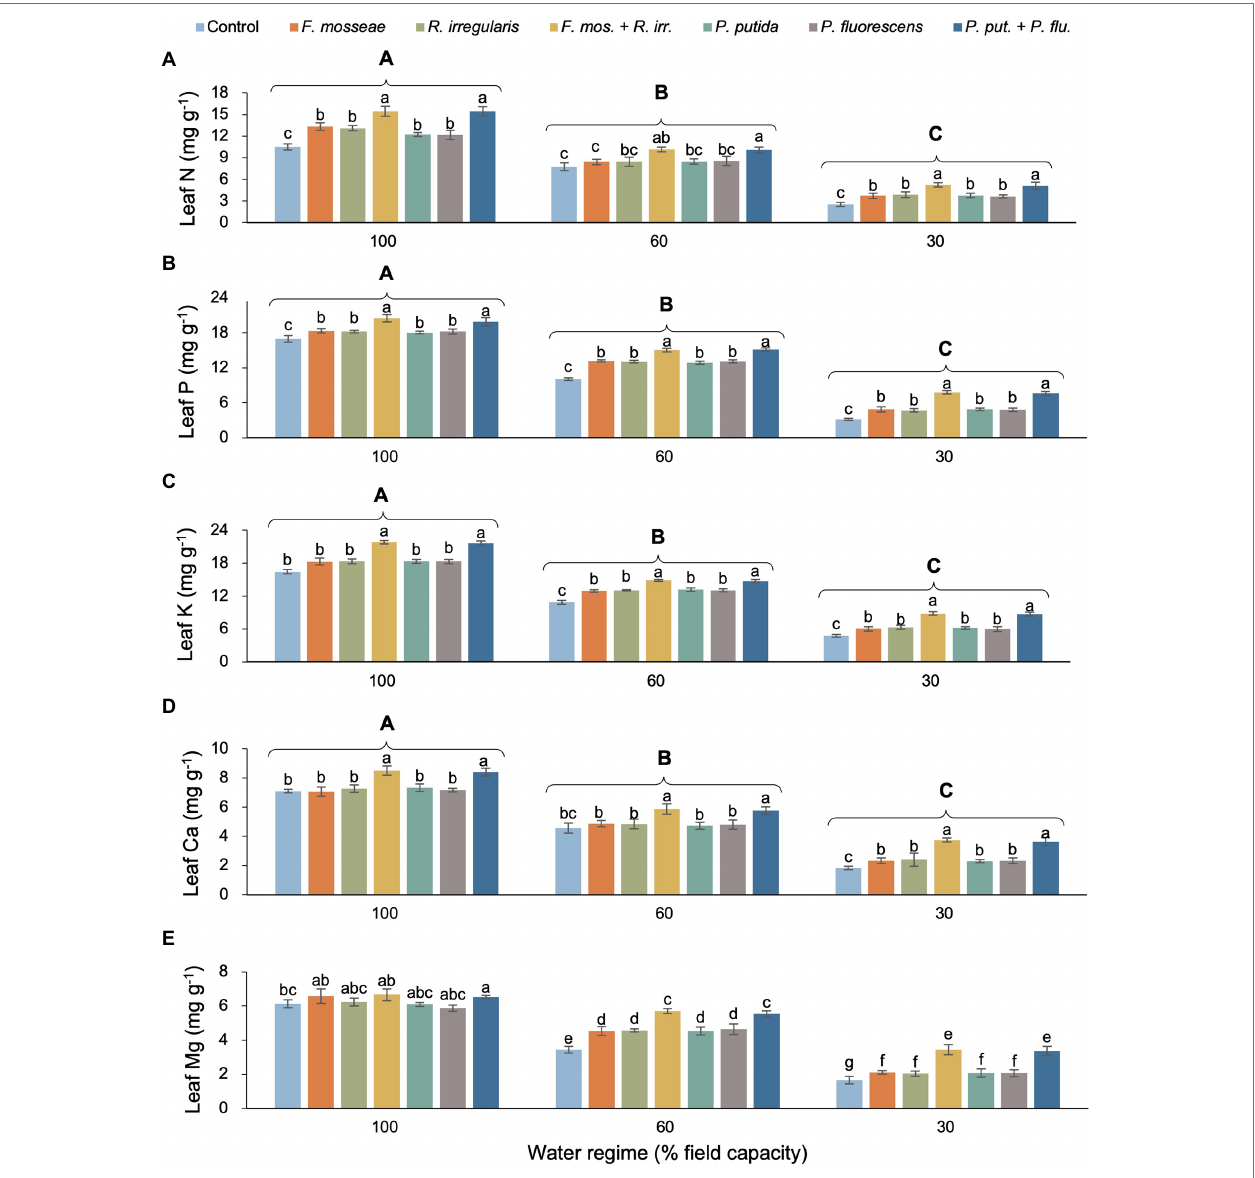
FIGURE 5 | Effect of water regime and soil microbial inoculation on leaf N (A) , P (B) , K (C) , Ca (D) , and Mg (E) of M. communis seedlings (expressed on a dry weight basis). Water regime and inoculation treatment had significant main effects on all shown leaf nutrients but a water regime × inoculation treatment interaction only occurred for leaf Mg ( Table 2 ). Therefore, different lower-case letters indicate significant differences between microbial inoculation treatments across water regimes for leaf Mg but only within water regimes in the remaining root nutrients (Duncan’s new multiple range test, α = 0.05). Different upper-case letters indicate significant differences between water regimes (Duncan’s new multiple range test, α =